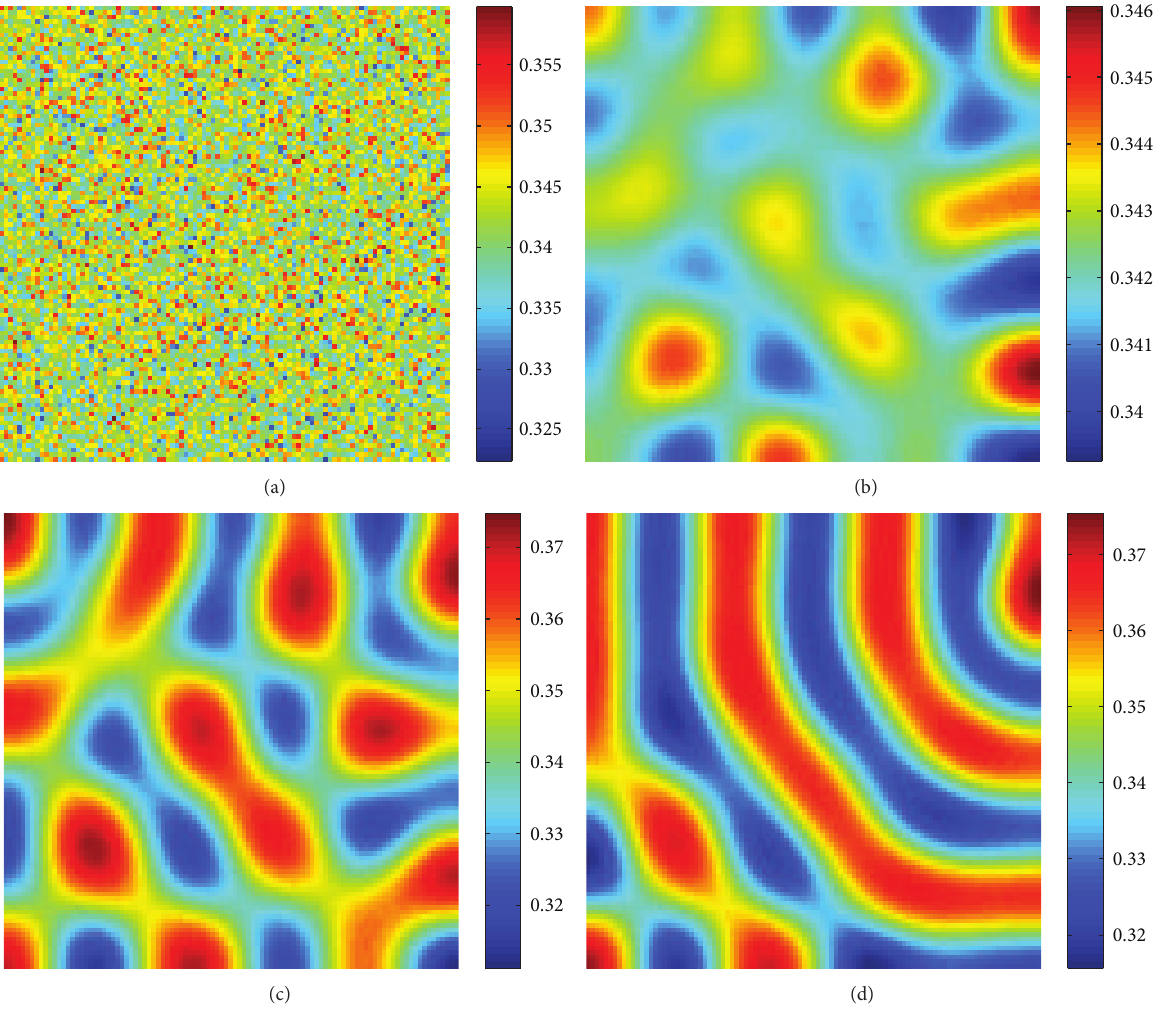
Figure 2: The formation of stripes patterns of prey 𝑢 with parameters 𝑏 = 0.495, 𝑐 = 0.5, 𝑘 1 = 0.3, 𝑘 2 = 0.2, 𝑚 = 0.3, 𝑠 = 0.25, 𝑑 1 = 0.1 , and = 2 . Time: (a) 𝑡 = 0 , (b) 𝑡 = 300 , (c) 𝑡 = 1000 , and (c) 𝑡 = 3000 𝑑 2